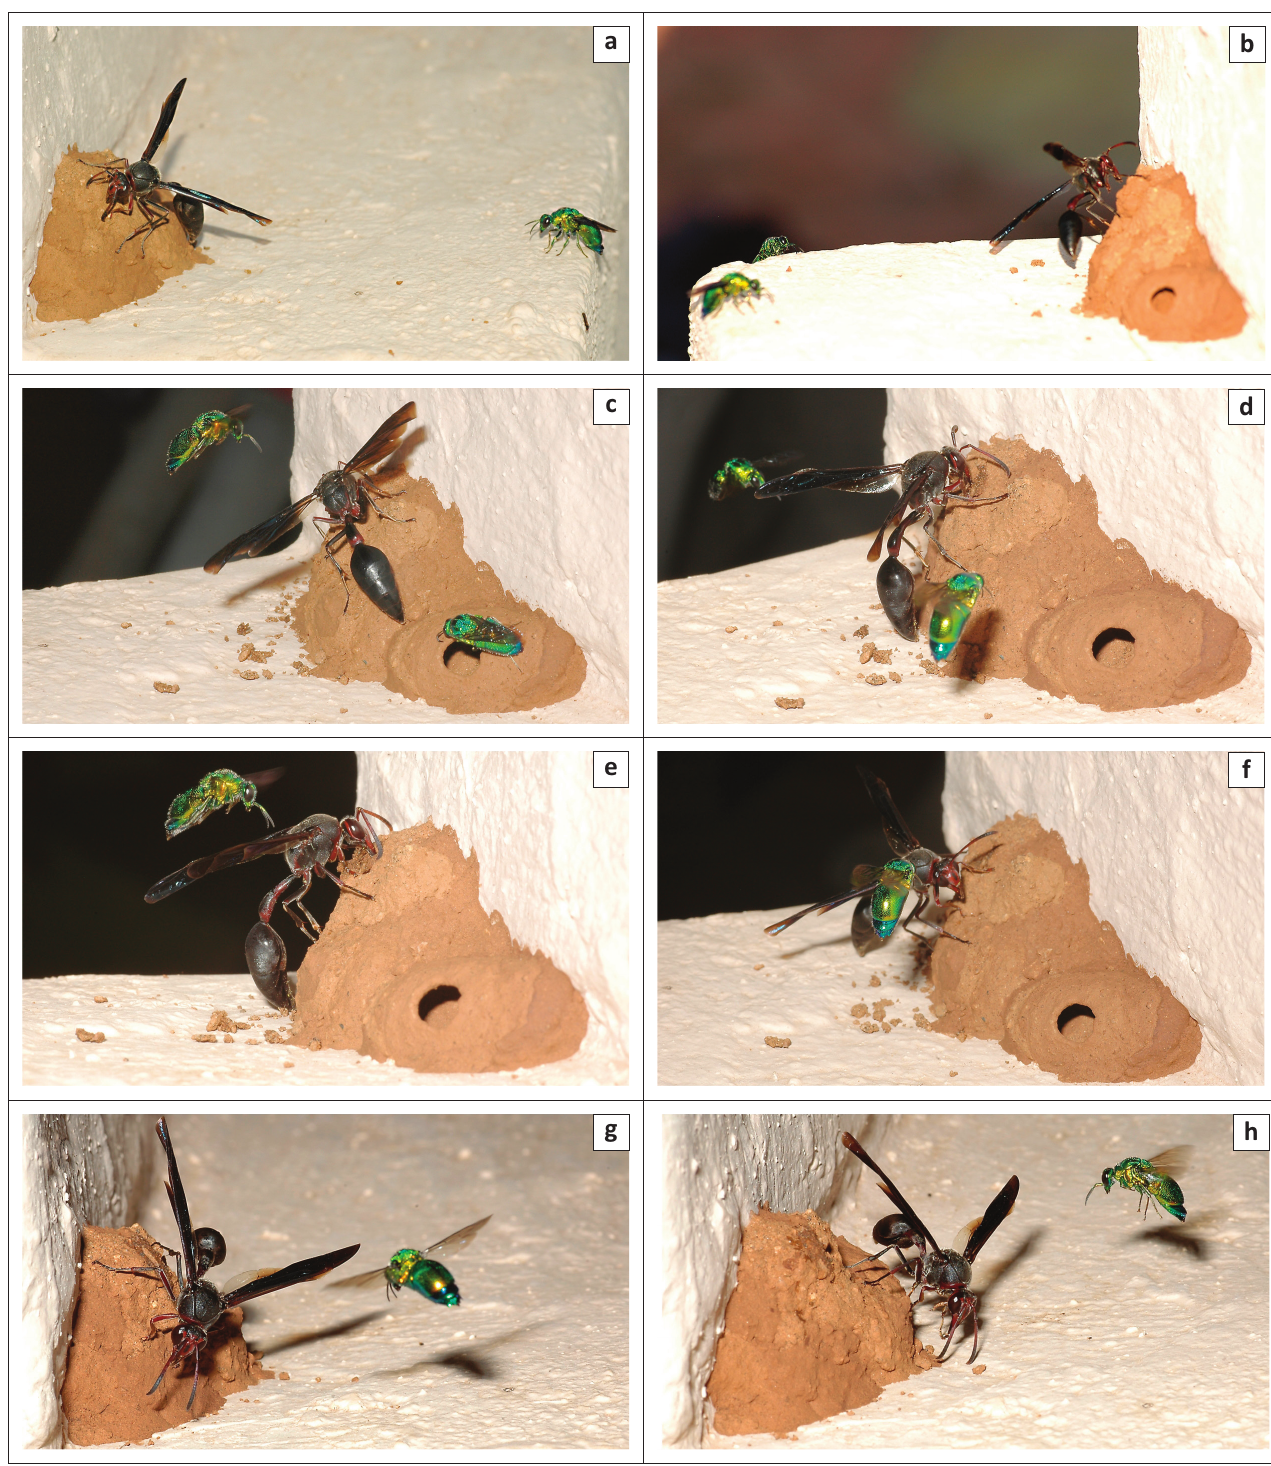
FIGURE 1: Nesting Delta sp. (Vespidae: Eumeninae) being attacked by two Stilbum cyanurum (Chrysididae) individuals. In between bouts of mobbing, the two S. cyanurum wasps would perch on the wall close to the nest (a)-(b). During bouts of mobbing, the two S. cyanurum wasps would simultaneously attack the Delta sp. from the air, actively harassing and dive-bombing her (c)-(h). The Delta sp. exhibited defensive behaviour, quivering her wings and facing her attackers, and would periodically fly at the mobbing S. cyanurum wasps (i) colliding with them in the air